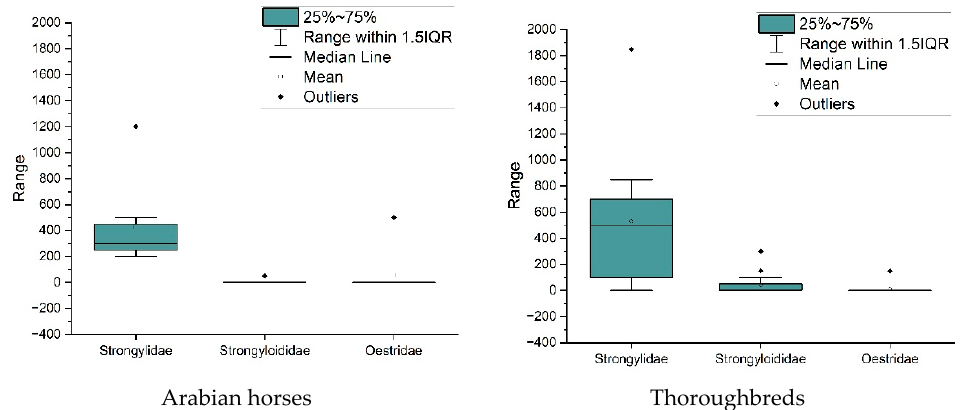
Figure 5. Box whiskers chart of numbers of eggs/larvae of parasites in stool samples of Arabian horses and Thoroughbreds.